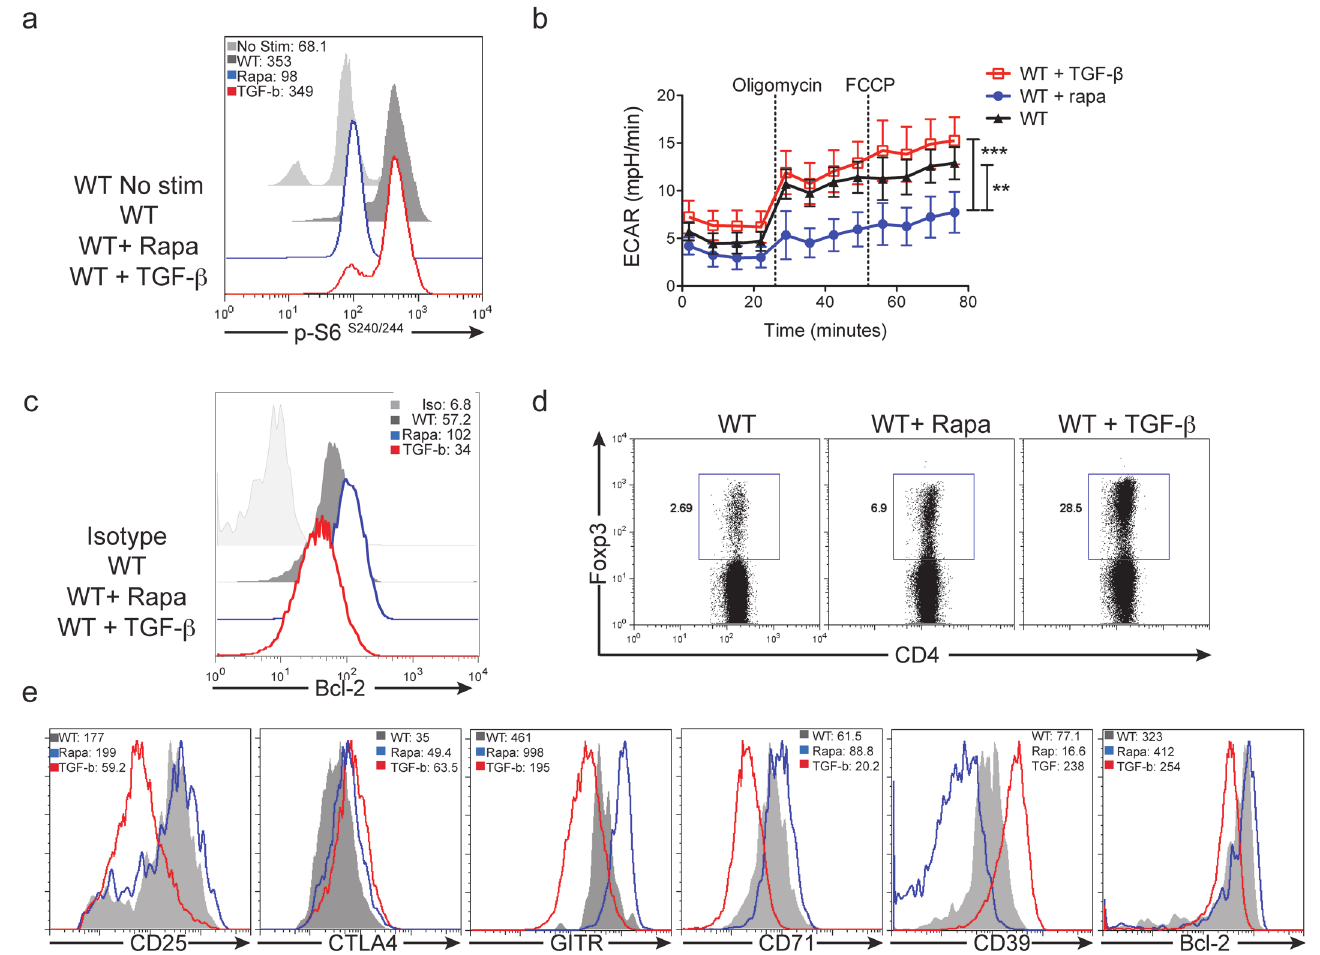
Fig 7. Foxp3+ CD4+ regulatory T cells exhibit divergent phenotypic profiles, dependent on their method of induction. Splenocytes from 5c.c7 Rag – / — TCR transgenic mice ( a ) or WT C57BL/6 mice ( b-e ) were stimulated with 1ug/ml soluble anti-CD3 and 1ng/ml IL-2 in the presence or absence of either 10ng/ml TGF-ß or 500nM rapamycin for 24hrs. a ) mTORC1 activity was measured by flow cytometric analysis of phosphorylated-S6 expression 24hrs after stimulation. Histograms were gated from activated CD4+CD69+ populations within each culture condition. b-e) After 24hrs of stimulation, cells were expanded in media supplemented with IL-2 alone, IL-2 + TGF-ß, or IL-2 + rapamycin for an additional 72hrs before phenotypic assessment. b) Cells were run on an extracellular flux analyzer and the extra cellular acidification rate, ECAR, was determined over time. c) Bcl-2 expression and d ) Foxp3 expression levels were assessed from CD4+ T cells of each culture condition. e) Histograms show shifts in MFI of markers associated with a T-reg phenotype. Populations were gated from Foxp3+ CD4+ T cells. The MFI of each population is shown in the upper corners of the FACS plots depicted in a,c,and e. The data are representative of 3 independent